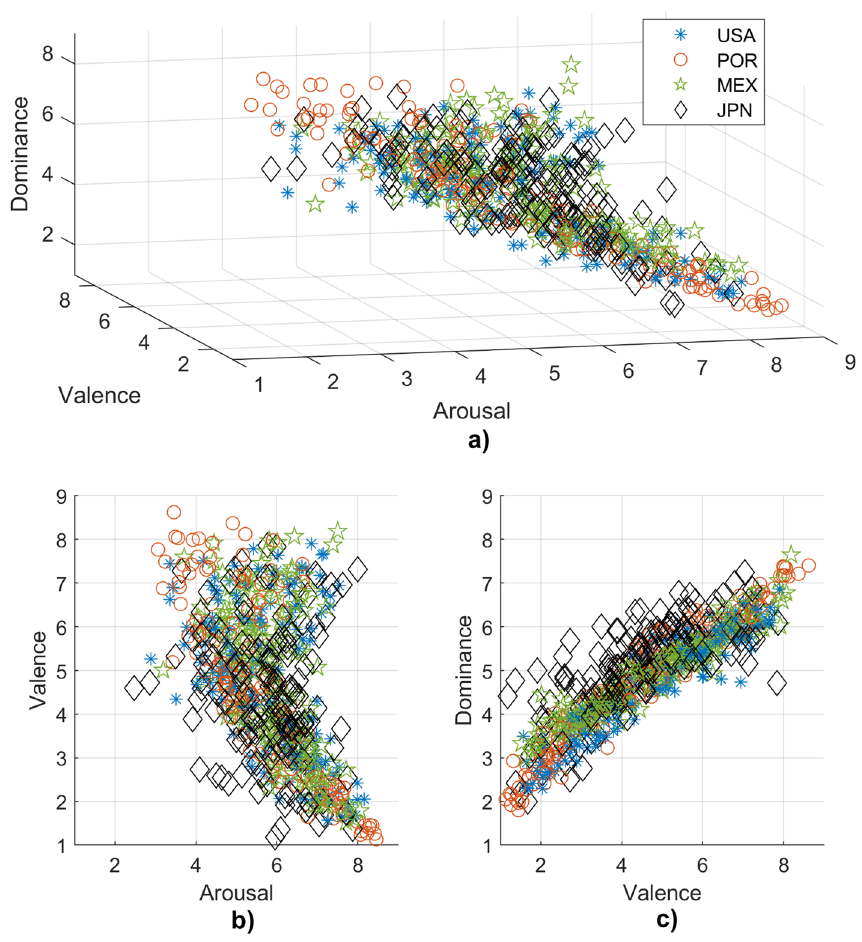
Figure 3. Distribution of mean ratings in the VAD model. The marker type indicates the mean ratings from SAM of different countries for the 167 IADS-2 sounds (167). For MEX, the 329 ratings were considered to calculate the mean rating of each sound. ( a ) Three-dimensional space. ( b ) Arousal-valence plane. ( c ) Valence- dominance plane.